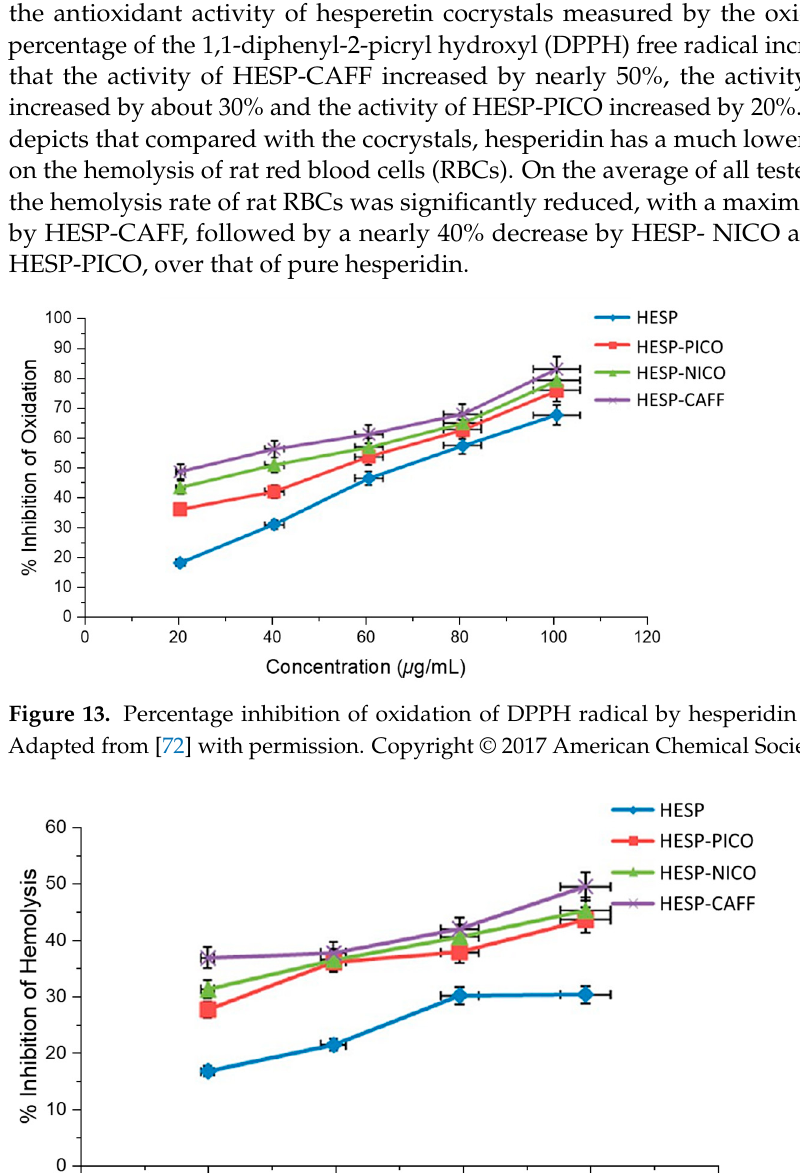
Figure 14. Antihemolytic activity represented as the percentage inhibition of hemolysis by hesperidin and the cocrystals. Adapted from [72] with permission. Copyright © 2017 American Chemical Society.